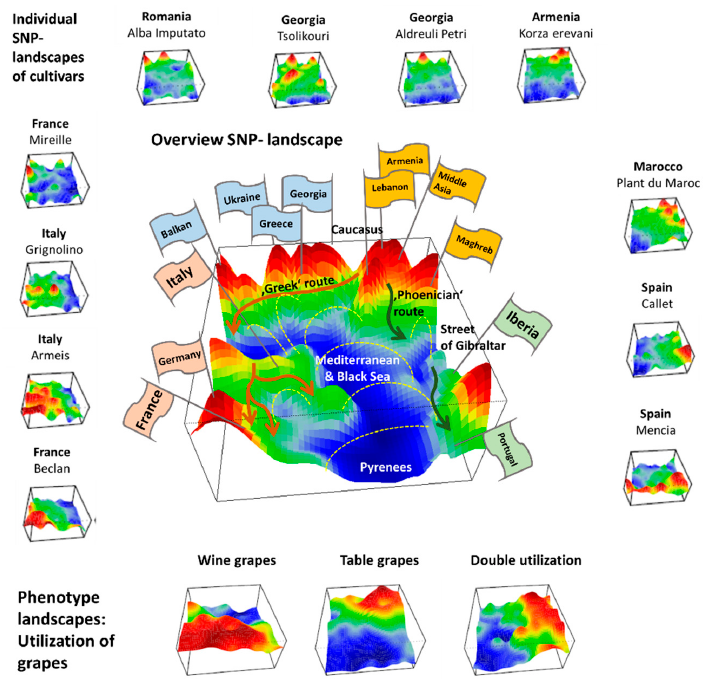
Figure 7. Genomic landscapes of grapevine cultivars: The SNP-landscapes of all 783 cultivars (examples (large image with flags). Correlated SNP-profile self-organized together due to